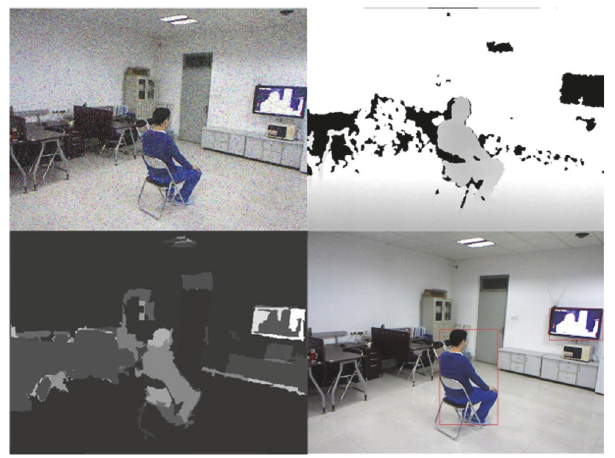
Figure 10: Illustration of cameras in intelligent space